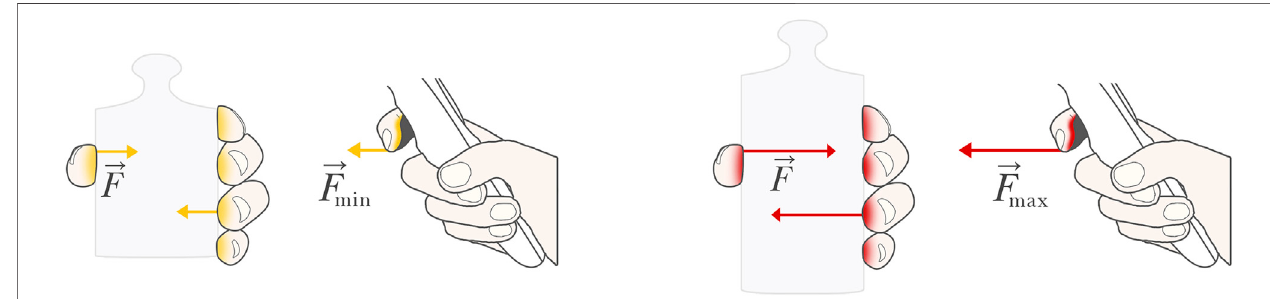
FIGURE 2 | Modulated fi nger forces from reality occurring during the grasping of objects with different weights are translated into the resistance of the trigger.